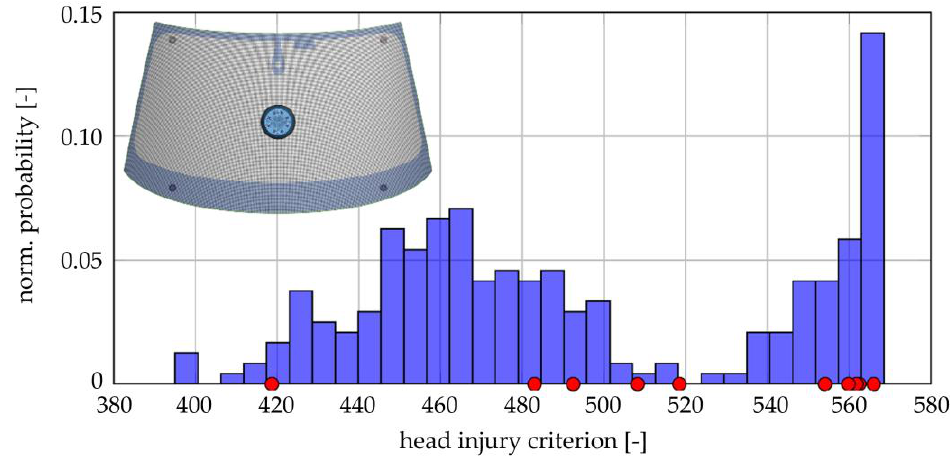
Figure 8. HIC probability for head impact tests on four-point supported windshields, cf. [11].